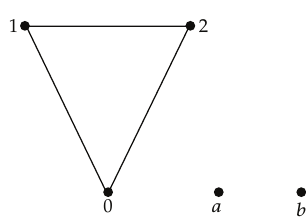
Figure 4: Associated graph Γ(cid:2) X (cid:3) of X